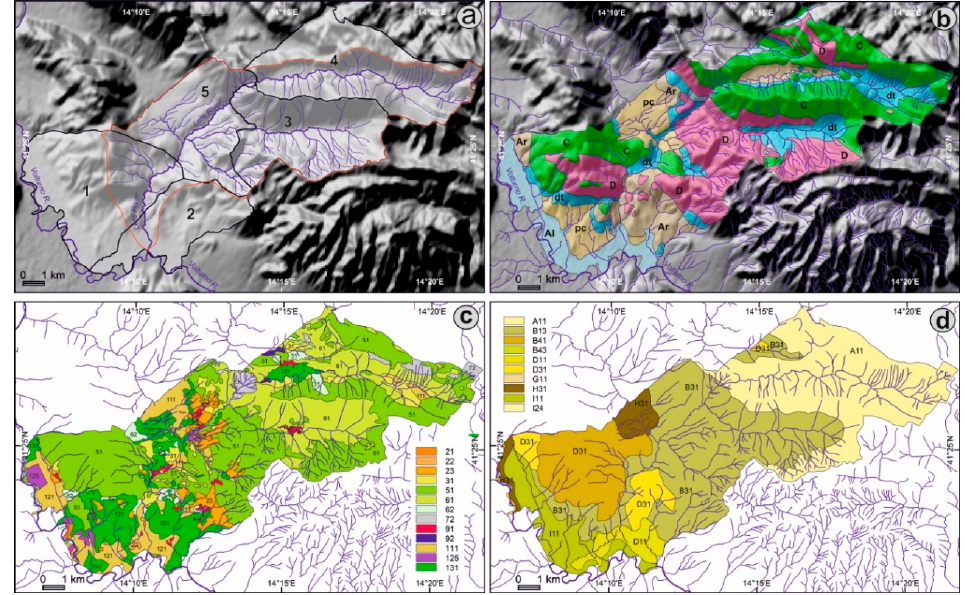
Figure 2. ( a ) Digital elevation model of the study area (Shuttle Radar Topography Mission dataset): location of area (in red) and boundary of municipalities (in black): 1—Pratella, 2—Ailano, 3—Valle